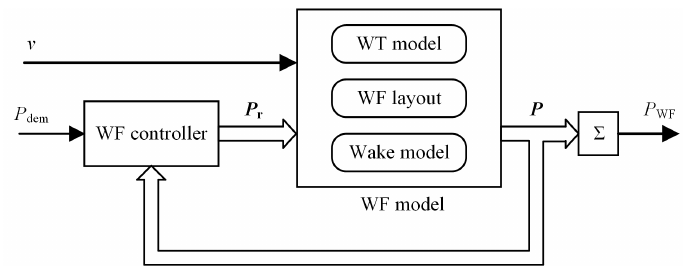
Figure 10. Control diagram of power dispatch.